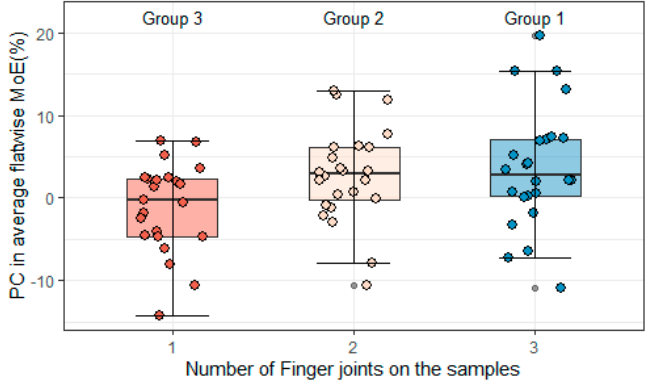
Figure 10. Percentage changes (PCs) in average flatwise MoE values.